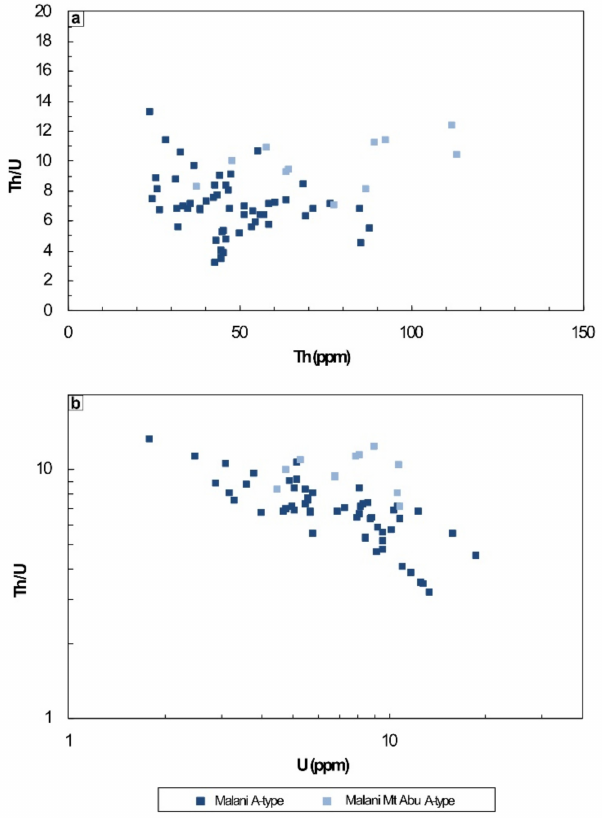
Figure 3. Th/U versus Th ( a ) and Th/U versus U ( b ) for the Malani A-type granites. Variscan